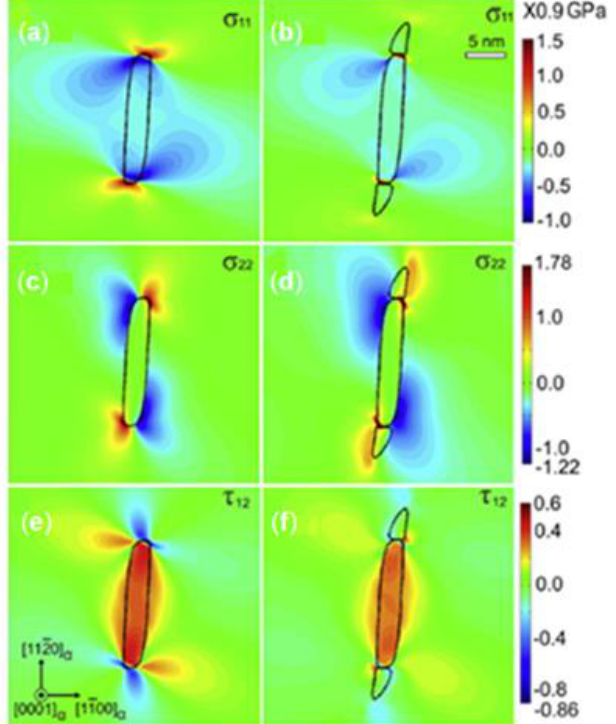
Figure 19. Stress fields around a 4.0 nm thick β (cid:48) precipitate without ( a , c , e ) and with ( b , d , f ) attached β (cid:48) particle on (0001) α F